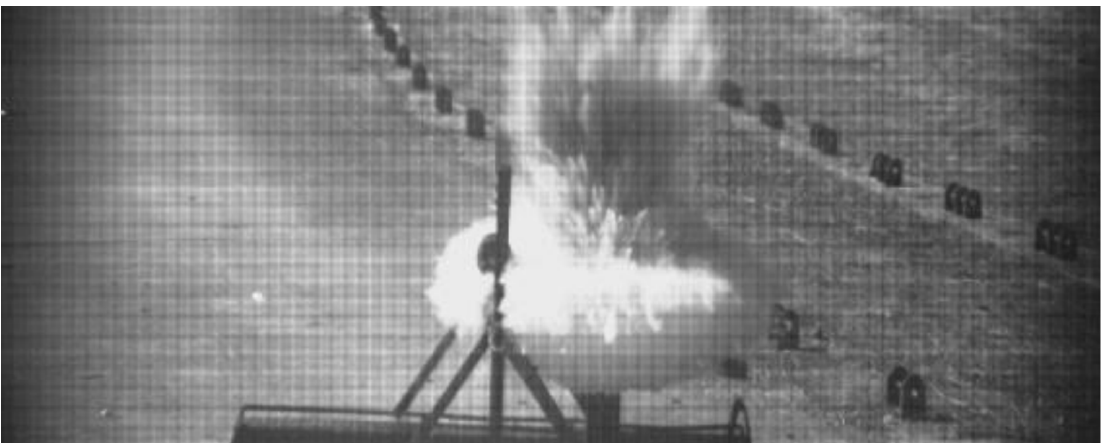
Figure 8. Image of test 1. A radial disk of water and water projected vertically upwards.